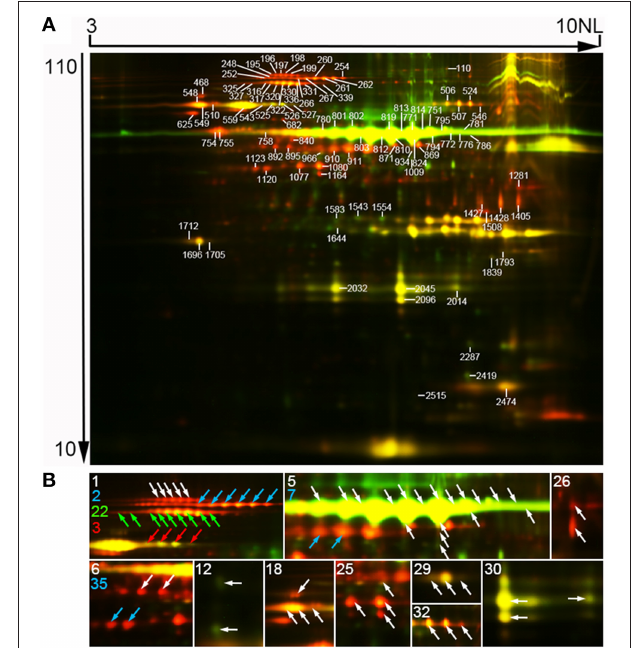
FIGURE 2 | Representative two-dimensional differential in-gel electrophoresis (2D-DIGE) images of SGAPs. (A) Representative image. Molecular mass (in kilodaltons) and pI of proteins were shown at the respective left and top of the image. Numbered spots representing identified differentially expressed protein spots. Original data of these spots were in Tables S1, S2, S6. (B) Close-up of isoforms of proteins from one protein-containing spots. Characters representing unipro number. Arrows colored same as a character indicating isoforms of the proteins. 1, plastidial starch phosphorylase (Pho1); 2, pullulanase (PUL); 3, soluble starch synthase I (SSI); 5, granule bound starch synthase (GBSS); 6, alanine aminotransferase; 7, ADP-glucose pyrophosphorylase 51 kD subunit (AGPase S2a); 12, glutelin; 18, heat shock 70 protein; 22, pyruvate orthophosphate dikinase 1 (PPDKB); 25, phosphoglycerate kinase; 26, glyceraldehyde-3-phosphate dehydrogenase; 29, desiccation-related protein PCC13-62; 30, germin-like protein 3; 32, chloroplastic outer envelope membrane protein; 35, actin. Raw data of isoforms and corresponding unipros were in Tables S4, S5, Supporting